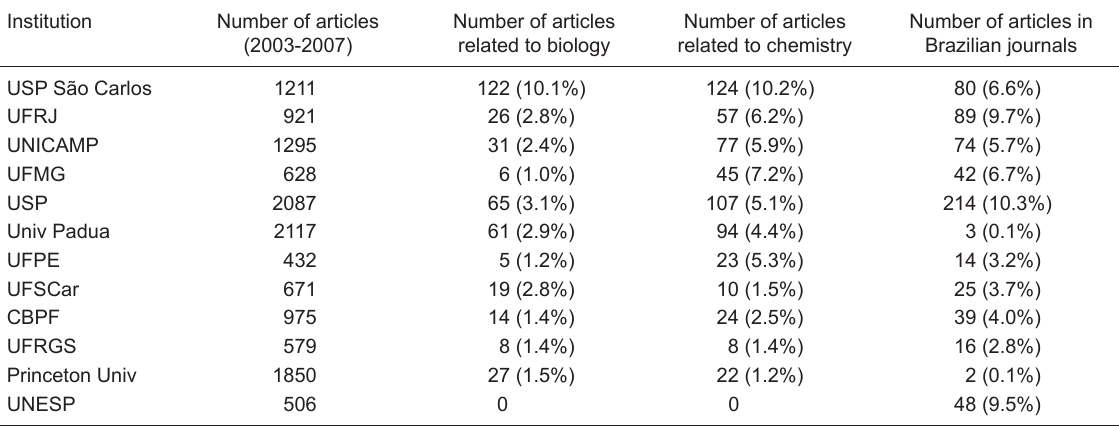
Table 4. Articles related to biology and chemistry published by the institutions of